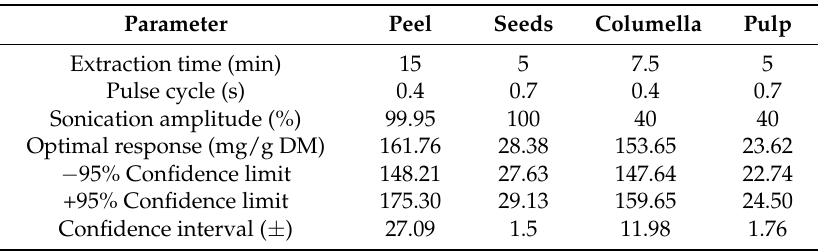
Table 4. Optimal conditions of ultrasonic-assisted extraction on soluble polyphenols from Annona muricata peel, seed, columella, and